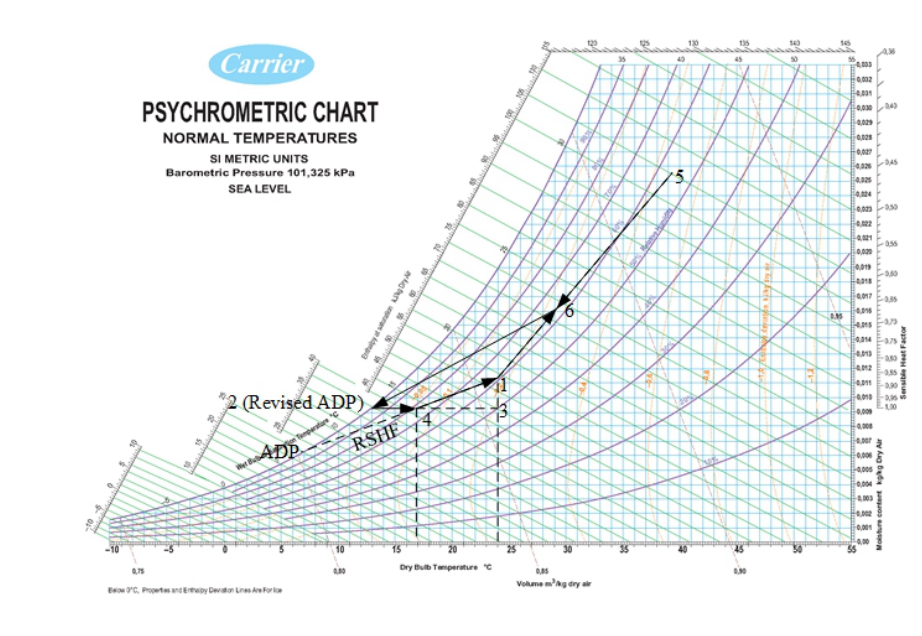
Figure 2. Sample building's psychrometric